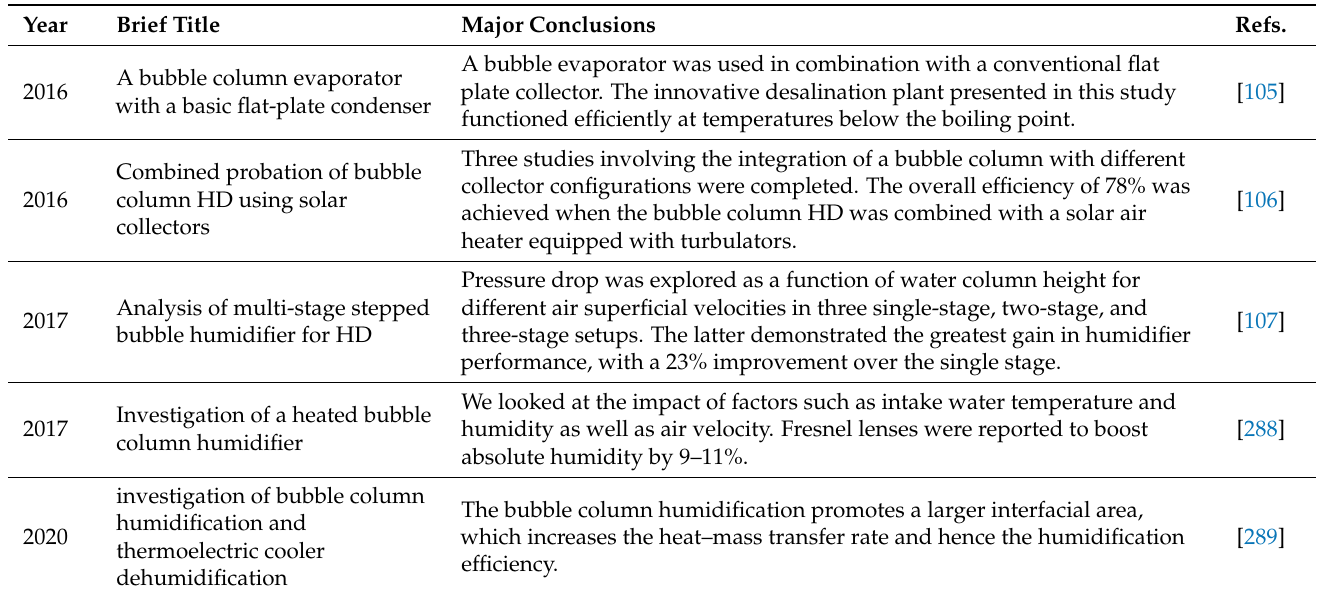
Table 9. A brief assessment of the experimental literature on the desalination method based on bubble